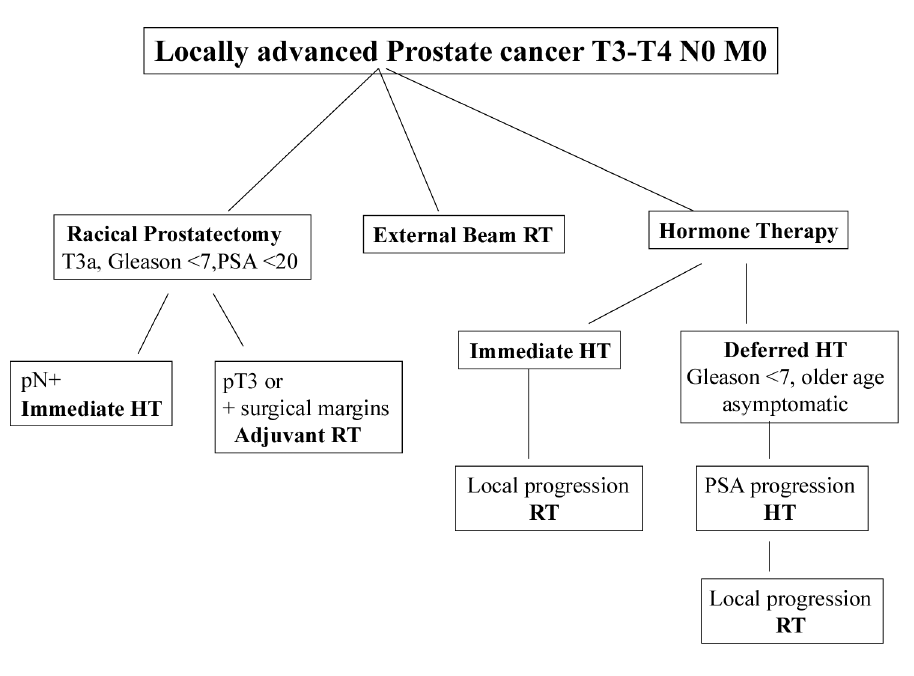
Figure 2 – Treatment options for T3-T4 N0 M0 prostate cancer candidates. Recommendation of the International Consultation on Prostate Cancer (ref. 7). HT = hormone therapy; R =